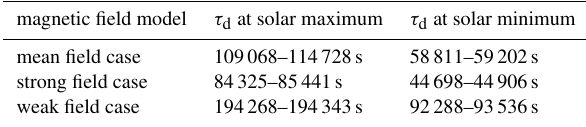
Table 1. Results from the diffusion time estimate. The symbol τ d stands for the diffusion time. The range in the table represents the choice for the mean ion mass (11.6 proton mass or 23.3 proton mass, values taken from Dubinin et al.,